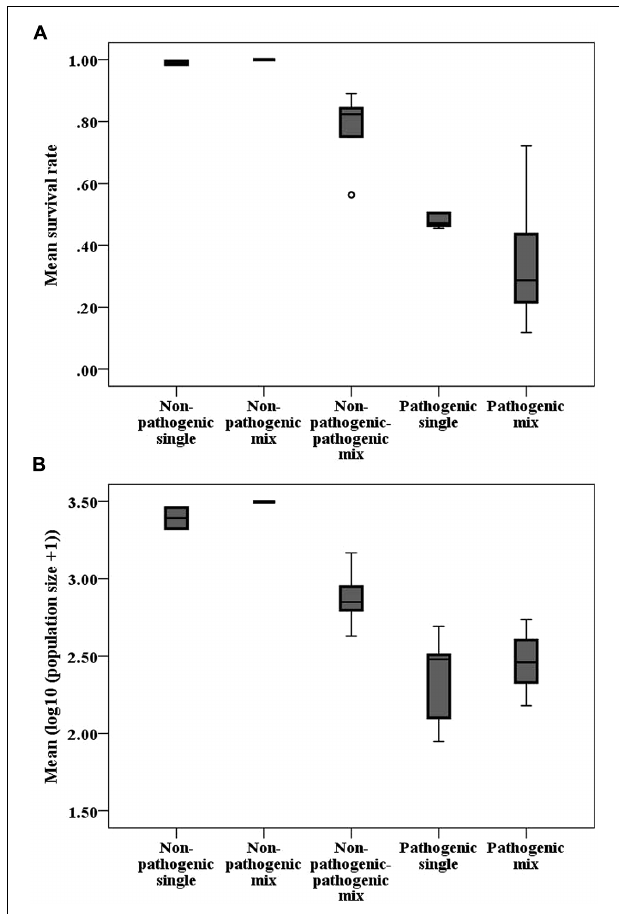
FIGURE 3 | Boxplots of (A) mean host survival rate and (B) mean logarithmic population size per strain combination of different treatments. The horizontal line indicates the median, the box the 25% quartile above and below the median, and the whiskers the data range. Circles represent outliers and stars represent extreme